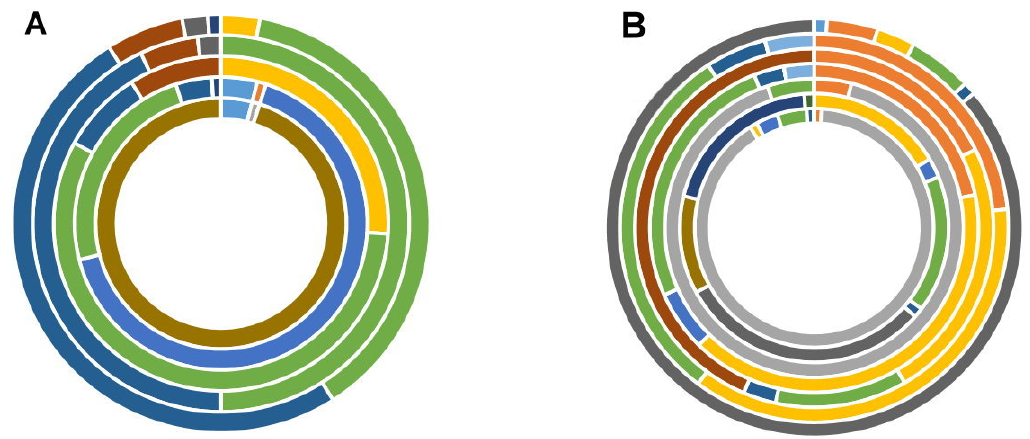
Figure 1. Distribution of mycotoxins for ( A ) ( n = 9 samples of laboratory animal feed for supplier 1). Key (from inner to outer ring): Feed batch S1A. NIV (95%), 15-ADON (4%), AFB 1 (1%). Feed batch S1F. DON (66%), ENNB (24%), 15-ADON (4%), ENNB 1 (4%), 3-ADON (1%), ZEA (1 %). Feed batch S1G. ENNB (57%), β-ZON (26%),